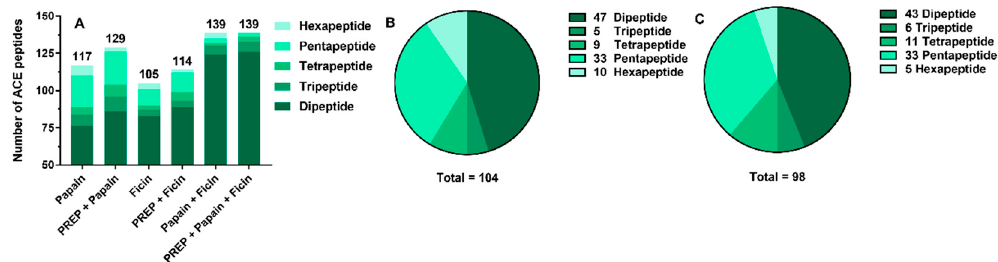
Figure 2. Number of ACE inhibitory peptides produced by di ff erent proteases in silico ( A ). Species of ACE inhibitory peptides released by hydrolysis using plant proteases without PREP ( B ) and with PREP ( C ) in silico. PREP was prolyl